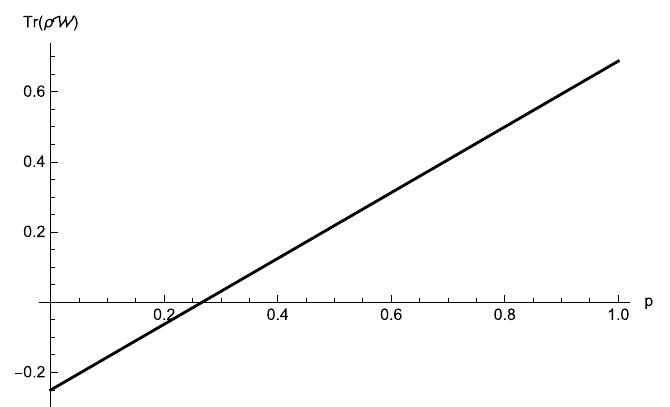
Figure 2. For the four-partite W state mixed with the white noise ρ 1 . The the black line represents Tr (ρ 1 W ) in Ref. 27 . We can see that ρ 1 is detected by the witness 3 4 I